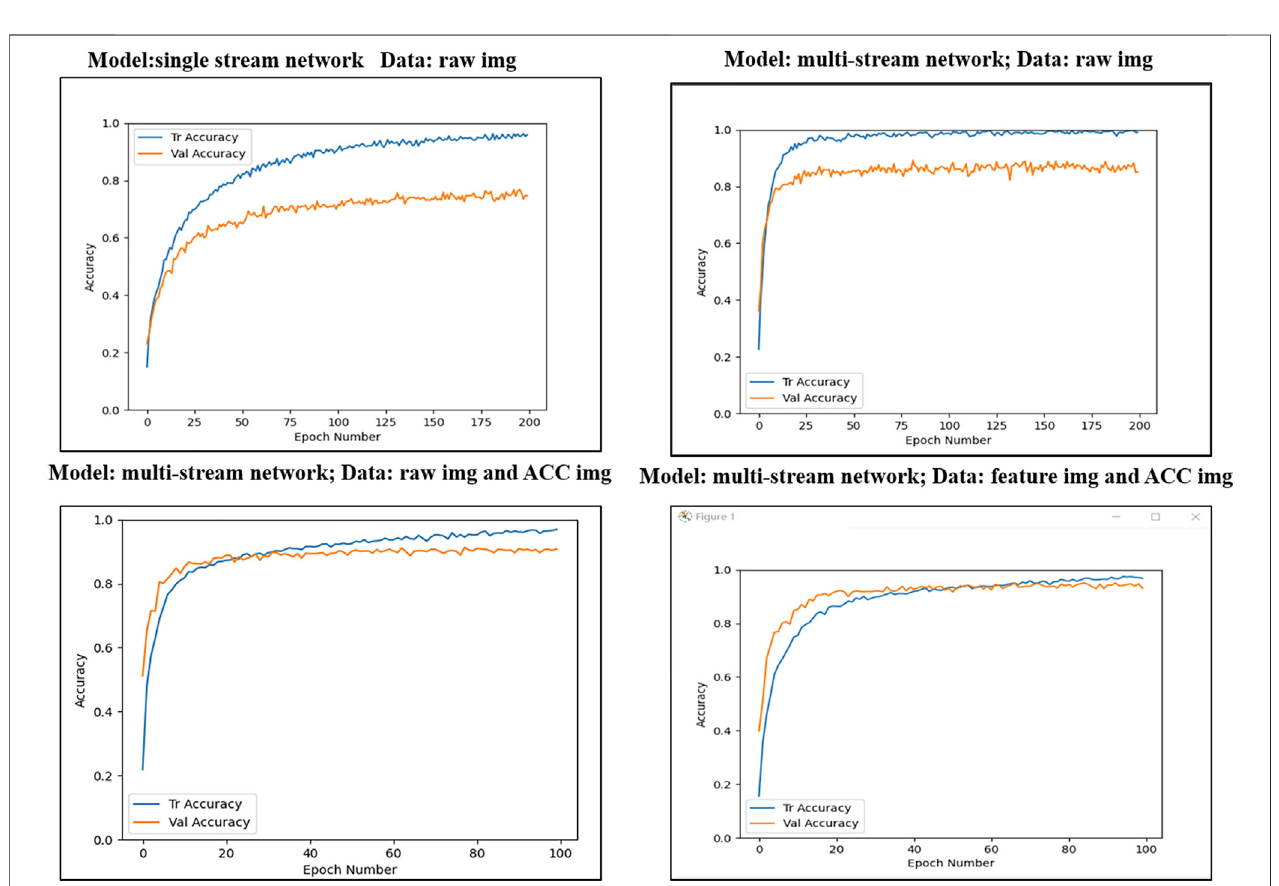
FIGURE 12 | Gesture recognition rate under different